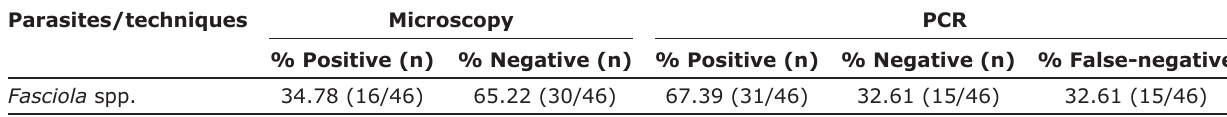
Table-1: Comparison between microscopy and PCR techniques for examining the prevalence of Fasciola spp. in beef cattle.